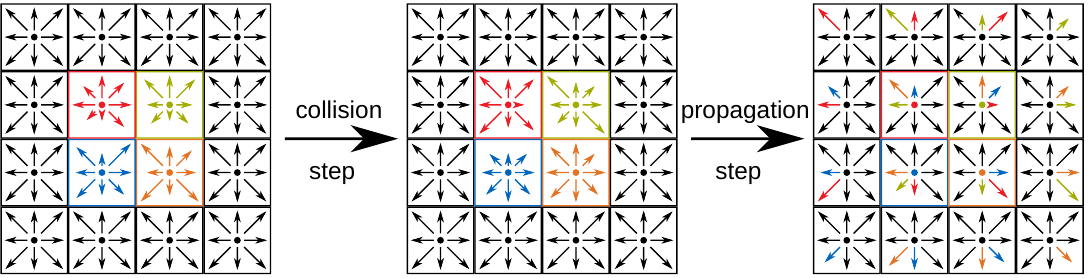
Figure 2. Probability densities of four processed cells (colored in red, green, blue, and orange) affected by collision and propagation steps [19]. Different lengths of same-color arrows in the same direction represent an update of the probability densities due to a collision